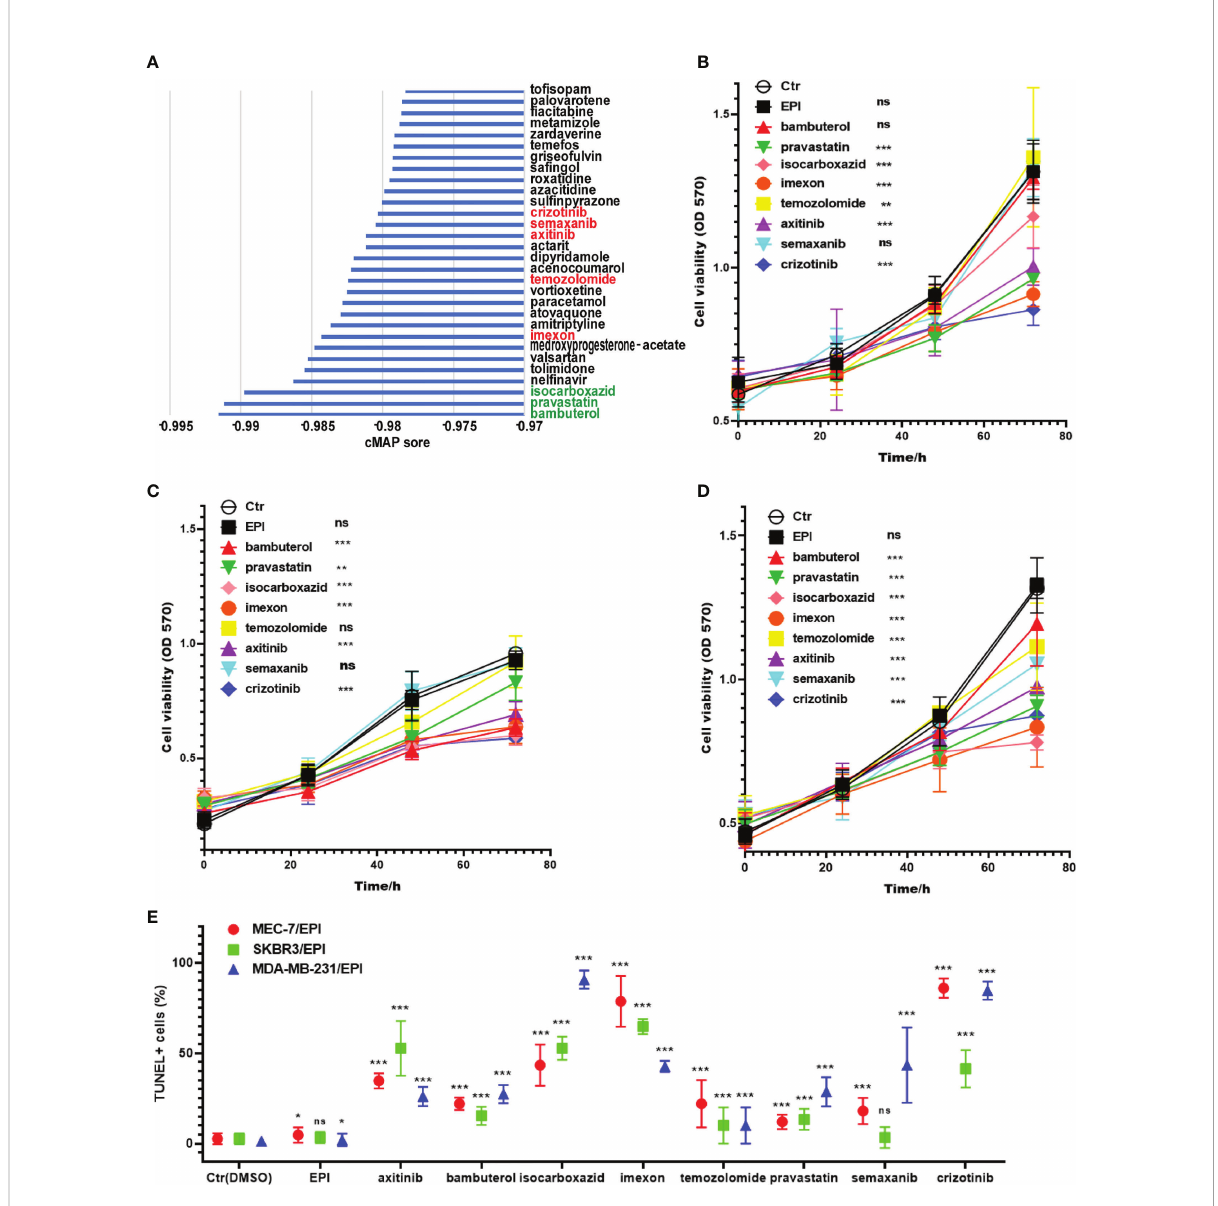
FIGURE 7 Screening potential drugs for the treatment of high-risk patients. (A) The potential drugs for the treatment of high-risk patients. The three best drug candidates are in the green font, and the known anticancer drugs in the TOP30 are in the red font. Cytotoxic effects of preferred drug candidates on MCF-7/EPI (B) , SKBR3/EPI (C) and MDA-MB-231/EPI (D) after 72 h of drug treatment. (E) The apoptosis level of cells in each group after 72 h of drug treatment. Data are presented as mean ± SD. *P < 0.05; **P < 0.01; and ***P < 0.001. ns, no signi fi